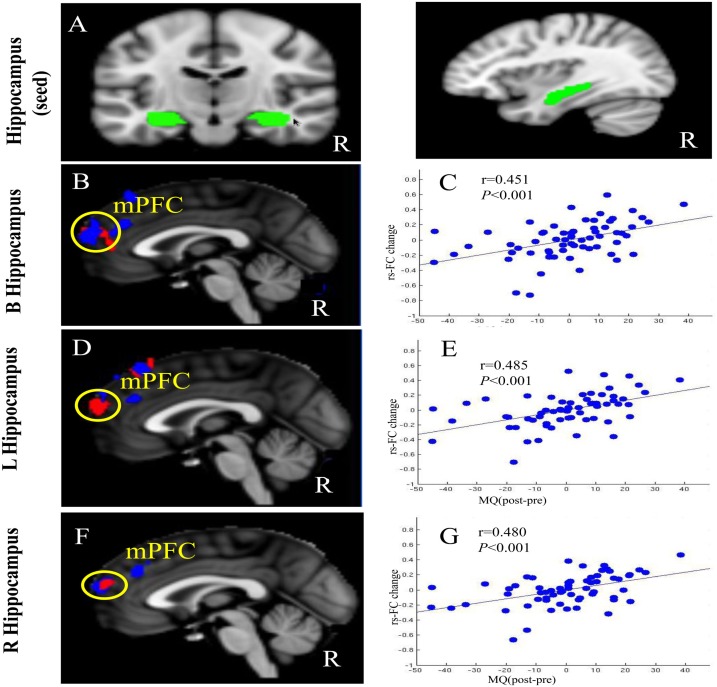
(A) Bilateral, left, and right hippocampus as seeds. (B,D,F) Significant resting-state functional connectivity changes in the Tai Chi Chuan group compared to the control group (red) and the brain regions that showed significant association between the connectivity increase and memory improvement (blue), overlapping in the mPFC. (C,E,G) Scatter plots indicate the correlation between memory quotient (MQ) and Fisher’s Z values at the peak of the significant cluster, corrected for age, gender, and years of education. B, bilateral; R, right; L, left.